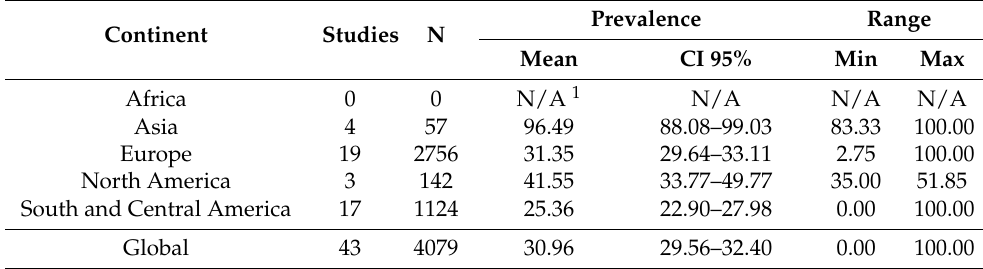
Table A9. Flock SLRV prevalence in each continent from 2011 to